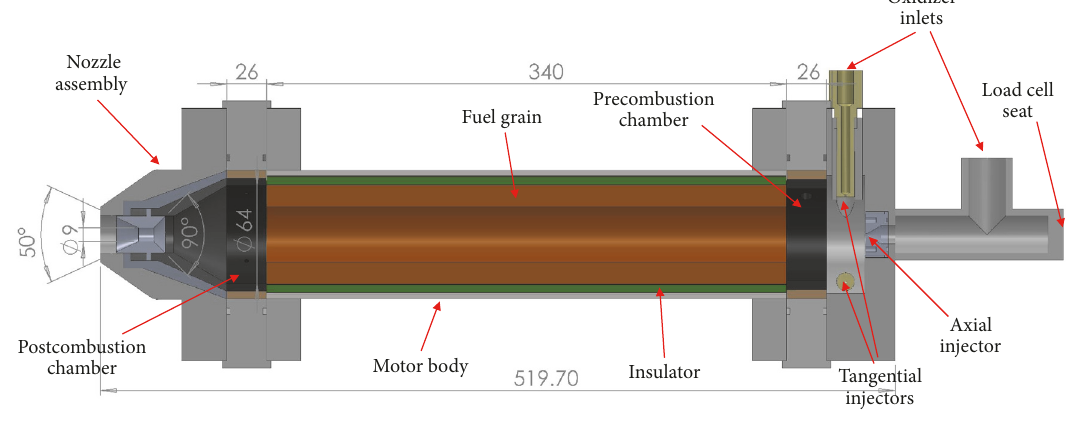
Figure 4: Subscale test hybrid